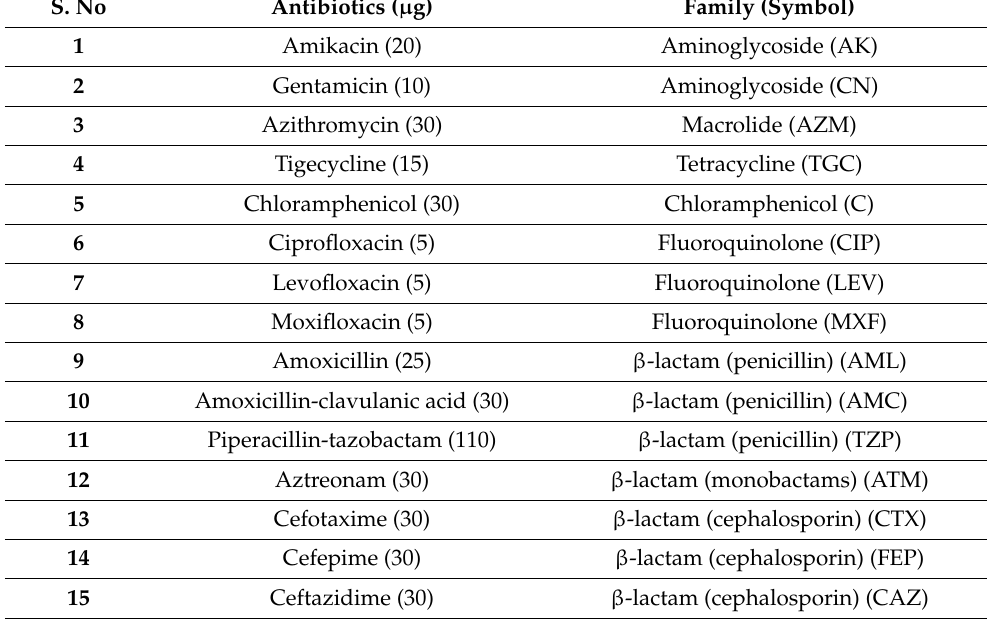
Table 2. List of